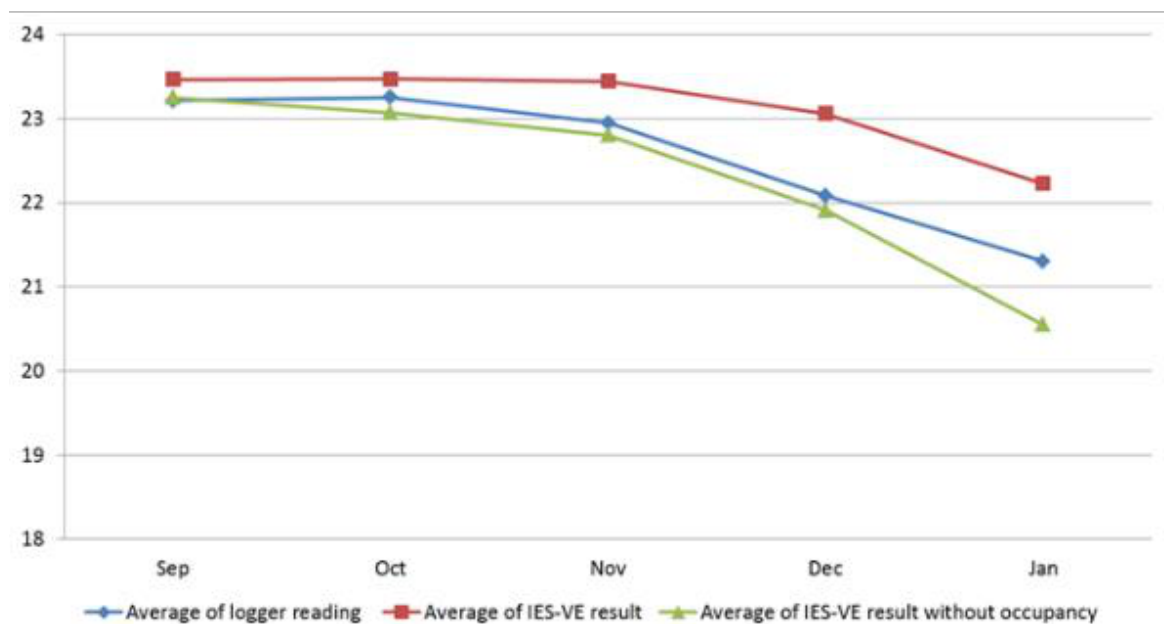
Figure 8a. Average measured and predicted monthly indoor temperature in PHV living